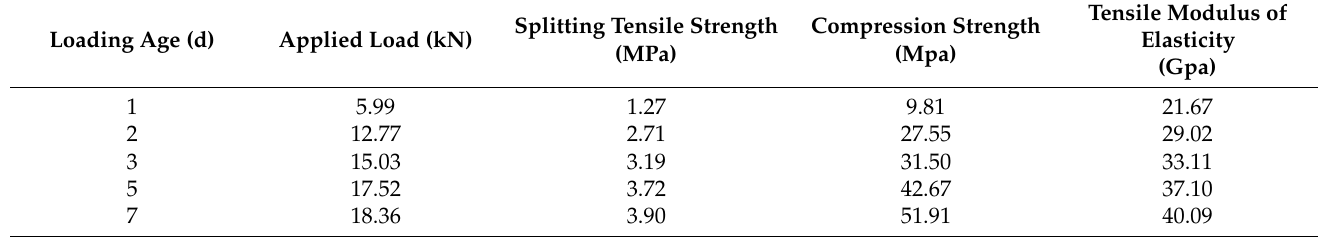
Table 4. Basic parameters of TC experiments and mechanical properties of HSC. ( W/B = 0.3, FA = 30wt